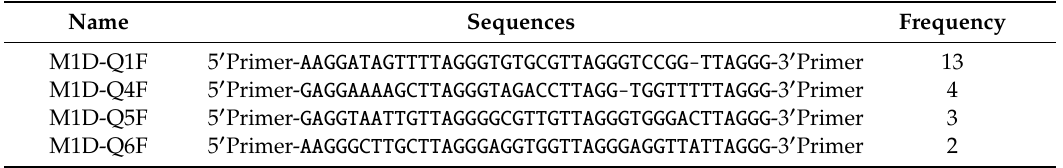
Table 1. Sequences of identified aptamer targeting B-loop of PPM1D430 from the IRDAptamer